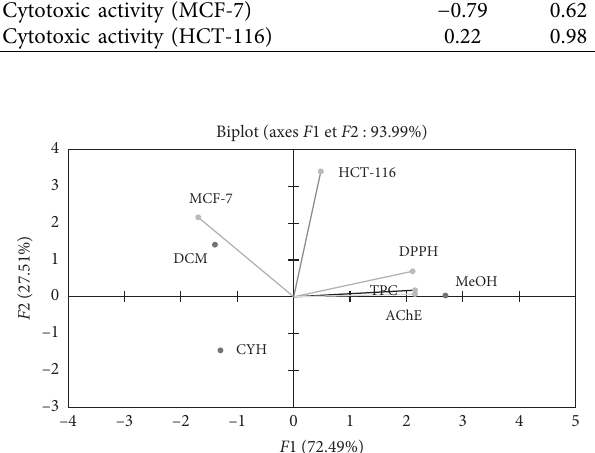
Figure 4: Principal components analysis biplot of antioxidant and biological activities of differents extracts of R. crispus . (CYH: cy- clohexane; DCM: dichloromethane; MeOH: